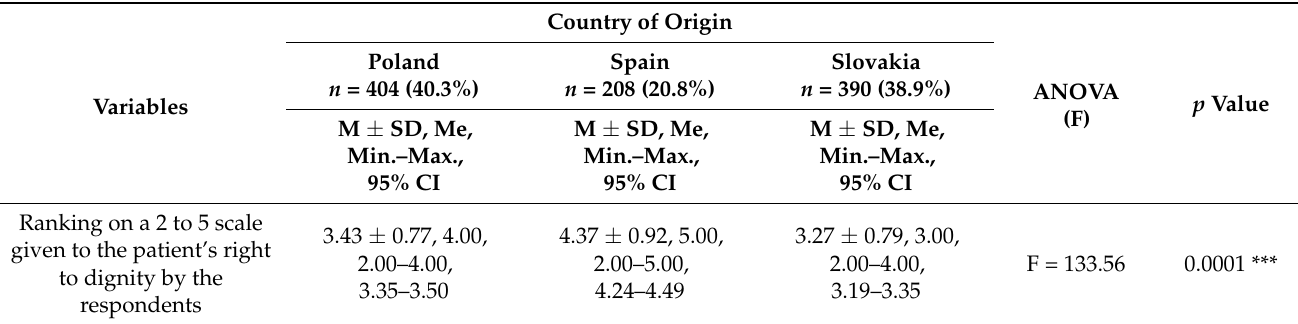
Table 3. Patients’ right to dignity—comparison of